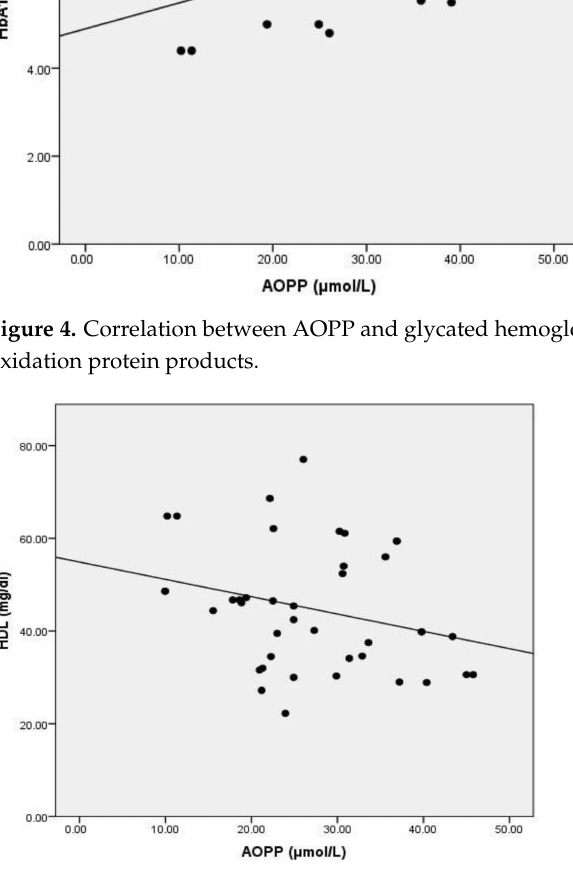
Figure 5. Correlation between AOPP and HDL-cholesterol. Legend: AOPP = advanced oxidation protein products; HDL = high-density lipoprotein.